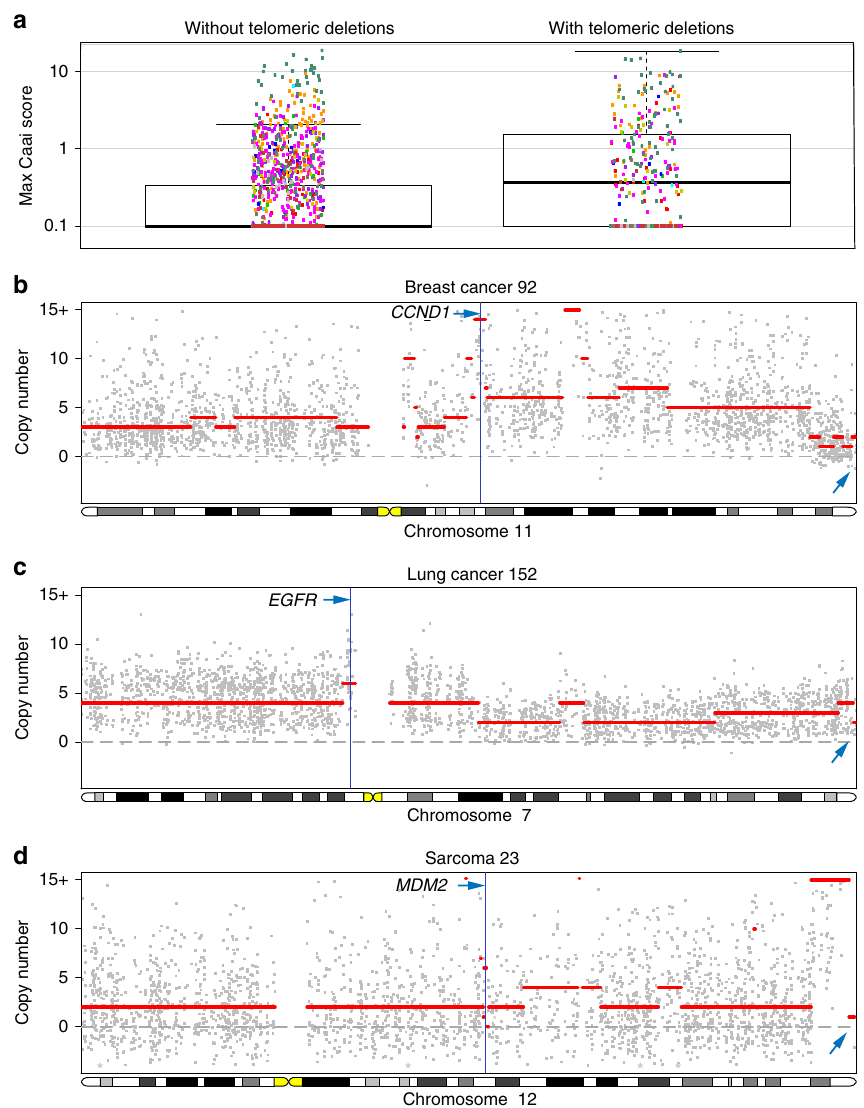
Fig. 5 Tumours with telomeric losses show more complex (oncogenic) rearrangements. a Maximum CAAI scores, quantifying the presence of regions with complex rearrangements 24 , for tumours with and without (sub)telomeric deletions. The increased genomic complexity in tumours with (hemizygous or homozygous) telomeric deletions is likely the product of breakage-fusion-bridge cycles initiated by these telomeric deletions. b – d Examples of ampli fi ed oncogenes in regions with high CAAI scores on chromosomes with telomeric